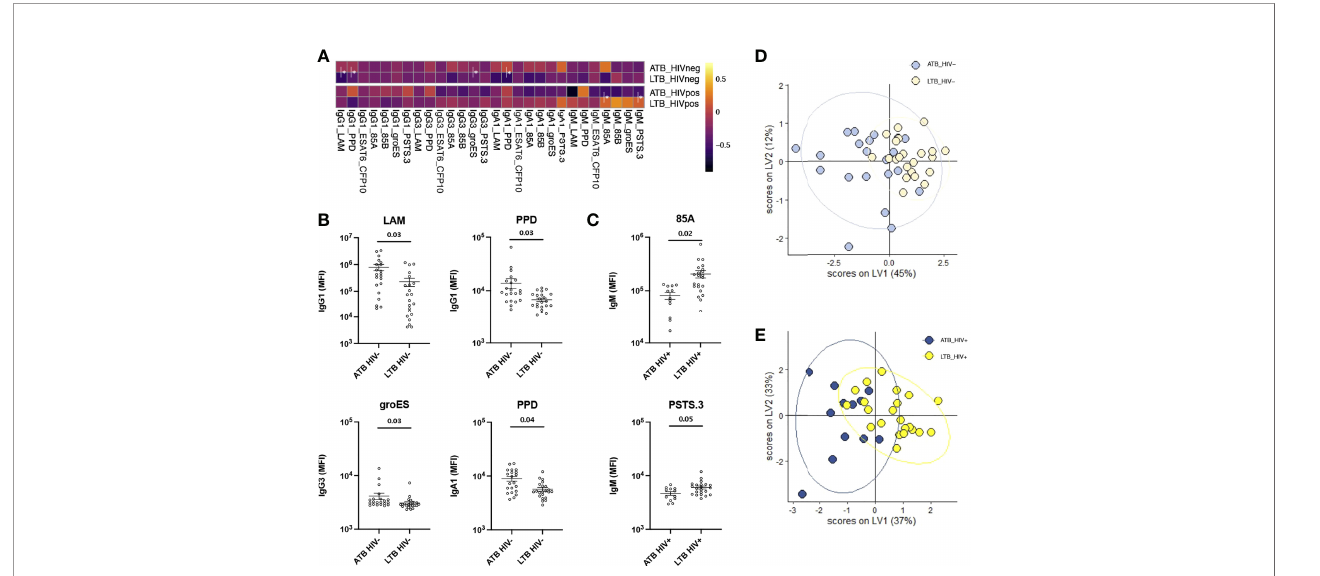
FIGURE 1 | Antibody levels against common Mtb antigens differ between ATB and LTB patients. Relative levels of IgG1, IgG3, IgA1 and IgM against 8 common Mtb antigens (LAM, PPD, ESAT6/CFP10, Ag85A and 85B, groES and PSTS3) were quanti fi ed via Luminex in the plasma of ATB (n=21) and LTB (n=22) patients in the HIV negative group and ATB (n=12) and LTB (n=22) patients in the HIV positive group. (A) For the heatmap, Z-score transformation of the MFI values was performed, and the median of each group was graphed. Antibody levels that are signi fi cantly different between ATB and LTB are graphed separately for all individuals in the HIV negative (B) and the HIV positive (C) groups. A Mann-Whitney U-test test followed by a Benjamini-Hochberg (BH) correction for multiple comparisons was used to test for statistically signi fi cant differences ATB and LTB. Multivariate analysis using LASSO and PLS-DA model shows antibody levels comparisons between ATB and LTB in HIV negative (D) and positive (E) populations. Cross-validation accuracy for (D, E) was 62.8% and 67.6%,